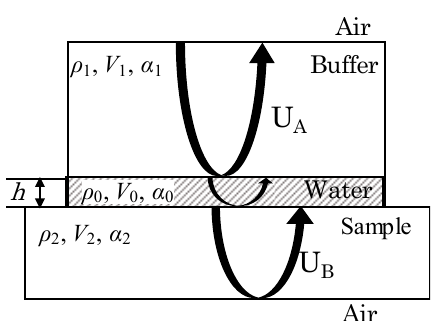
Figure 2. Effect of the coupling layer: coupling layer thickness is h and the medium is water.